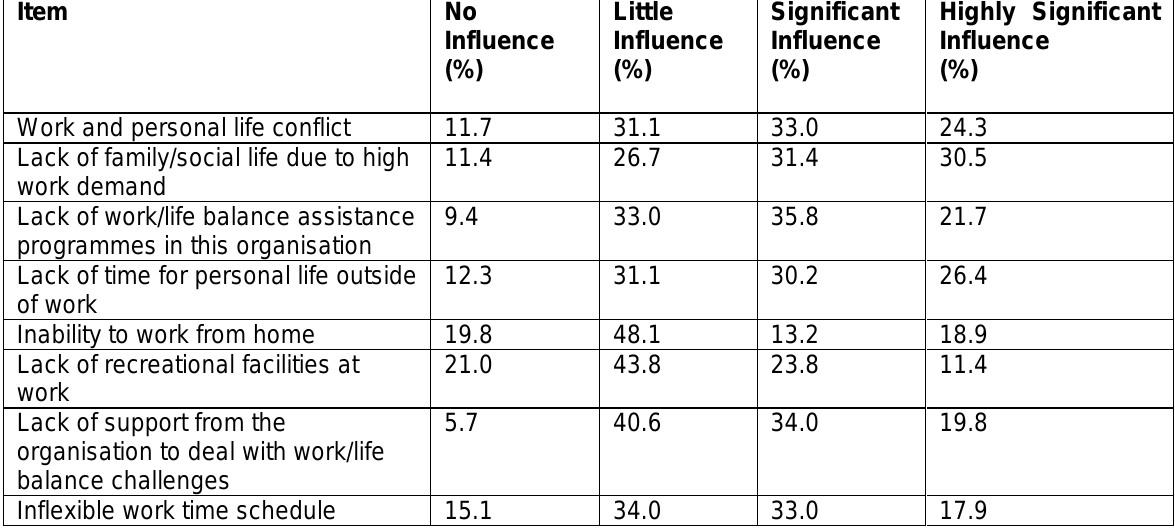
Table 6: Perceived i nfluence of work/life balance issues on the respondents’ consideration to leave